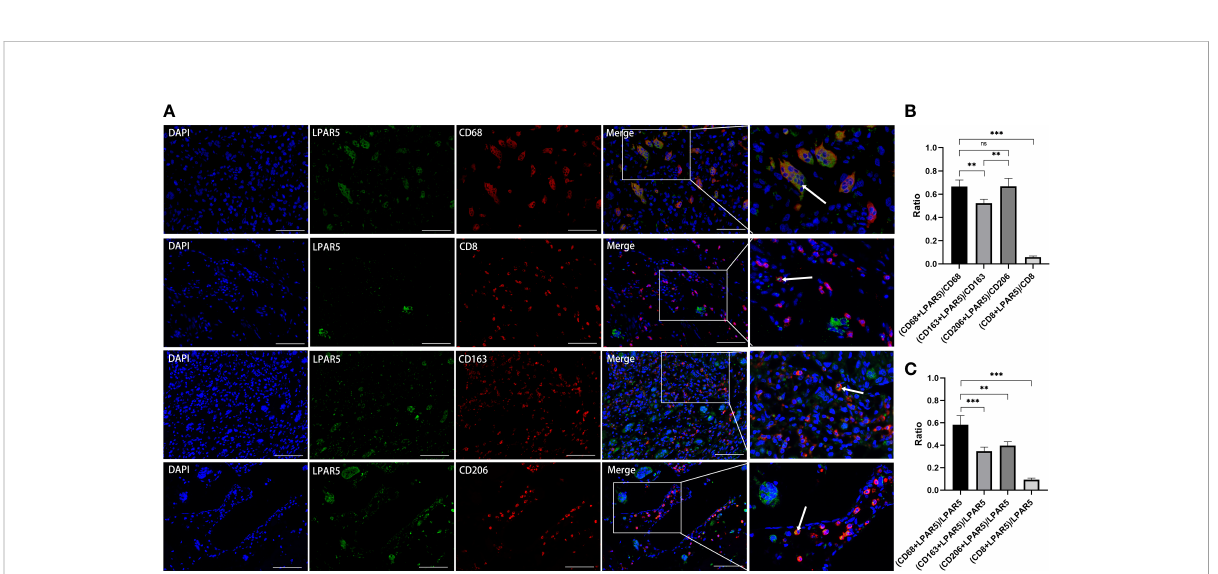
FIGURE 12 Immuno fl uorescence staining. (A) Immuno fl uorescence staining of LPAR5, CD68, CD163, CD206 and CD8. (B) The proportion of LPAR5 positive expression in CD68+ macrophages, CD163 + macrophages, CD206 + macrophages and CD8 + T cells. (C) Comparison of CD68 + macrophages, CD163 + macrophages, CD206 + macrophages and CD8 + T cells in LPAR5-positive cells. Co-localization was highlighted with white arrows. Scale bars: 100 m m. **: P<0.01; ***: P<0.001; ns, not signi fi